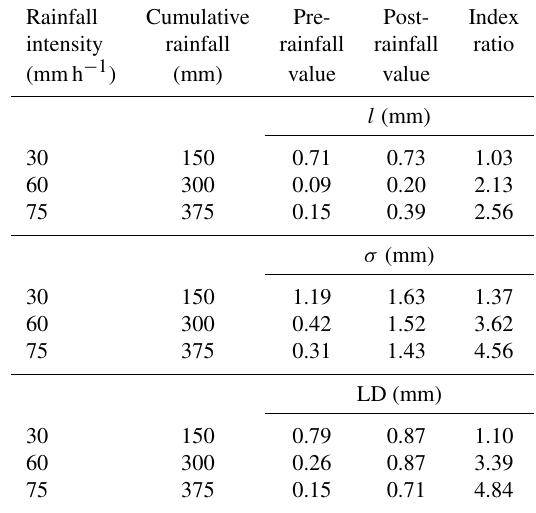
Table 2. Summary of the rainfall-induced change in the crossover length, the Markov–Gaussian variance length scale and limiting dif- ference indices for the experimental tests of this